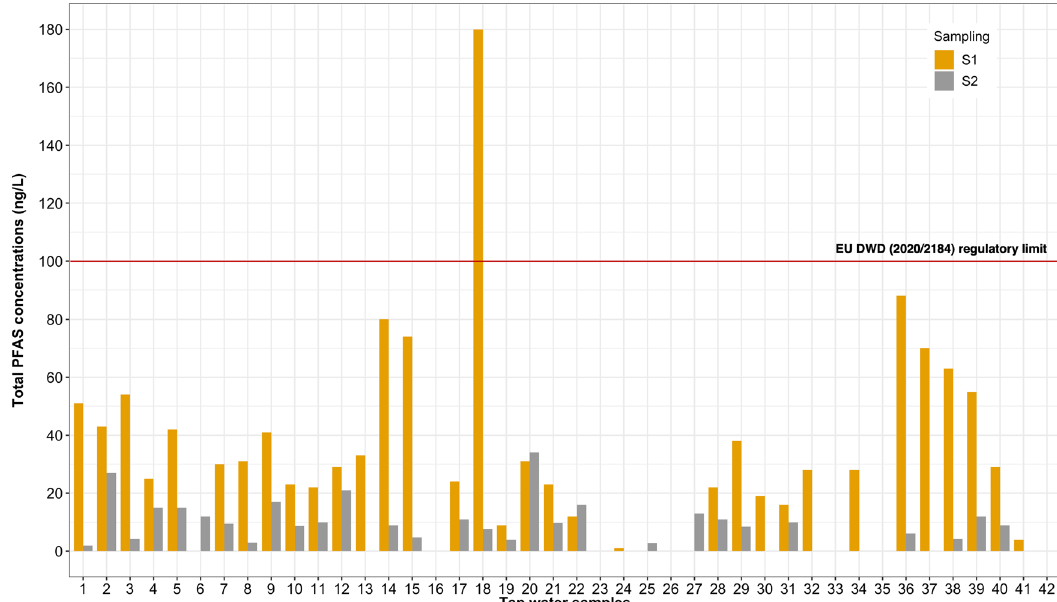
Fig. 4 Total PFAS concentrations (ng/L) in un fi ltered tap water samples collected in residential locations ( N = 42). S1, fi rst sampling (August – October 2020); S2, second sampling (May 2021). PFAS were below the quanti fi cation limit for the following locations 16, 23, 26, 33, 35, 42 (in S1 and S2); 25, 27 (in S1); and 24, 32, 34, 41 (in